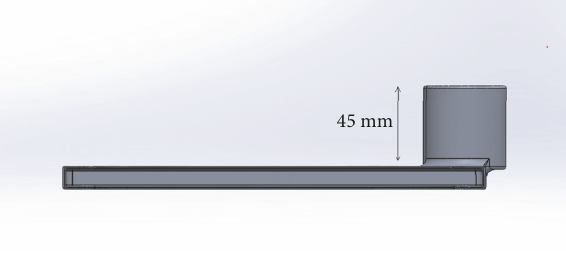
Figure 2: Grip of the Cyclops.